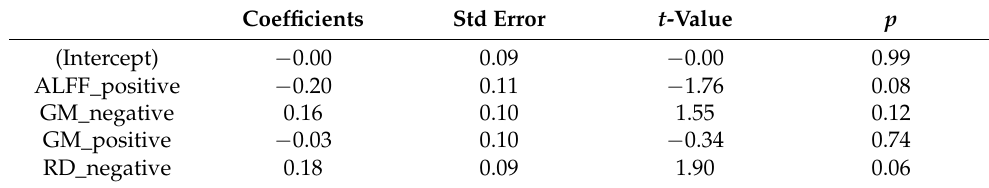
Table 2. The results of general regression for four neural variables and the RSA (Resilience Scale for Adults) subscale of personal strength (RSA_p).